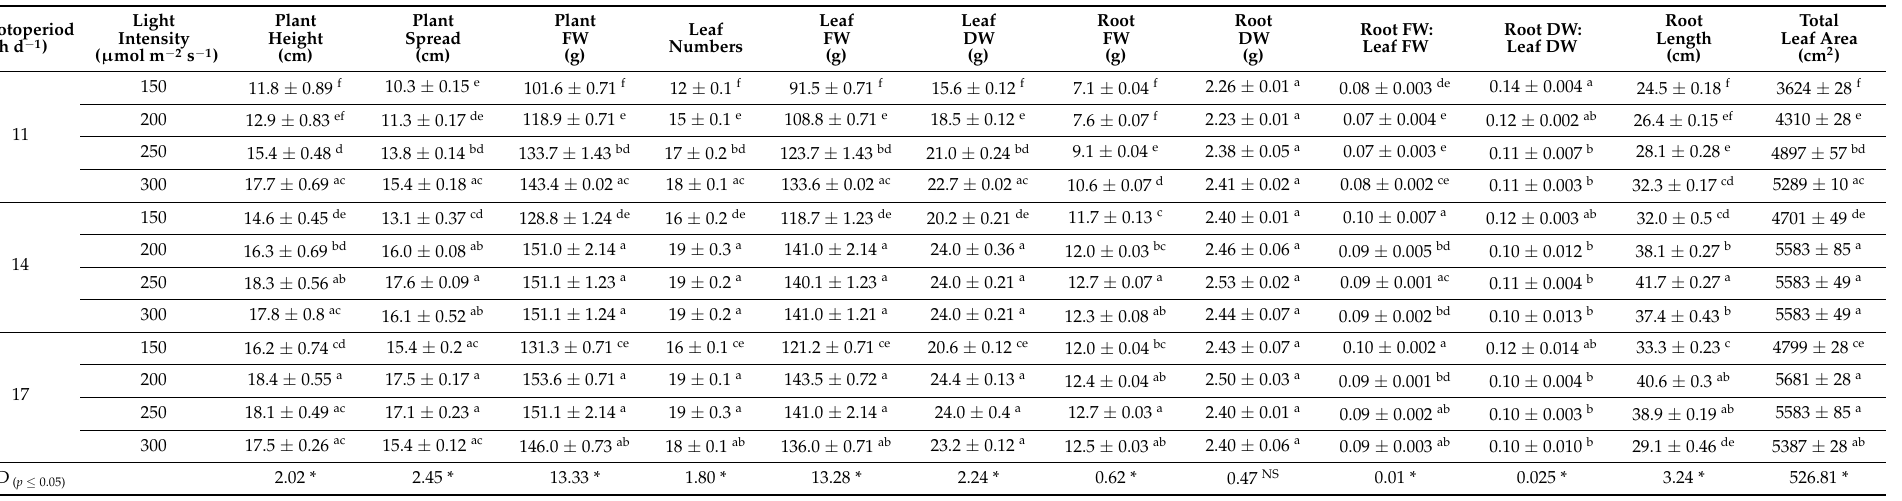
Table 1. Different growth attributes of glasshouse-grown butterhead lettuce cv. Gustav under various photoperiod and light intensity combinations. The FW and DW in the table represent the fresh weight and dry weight,